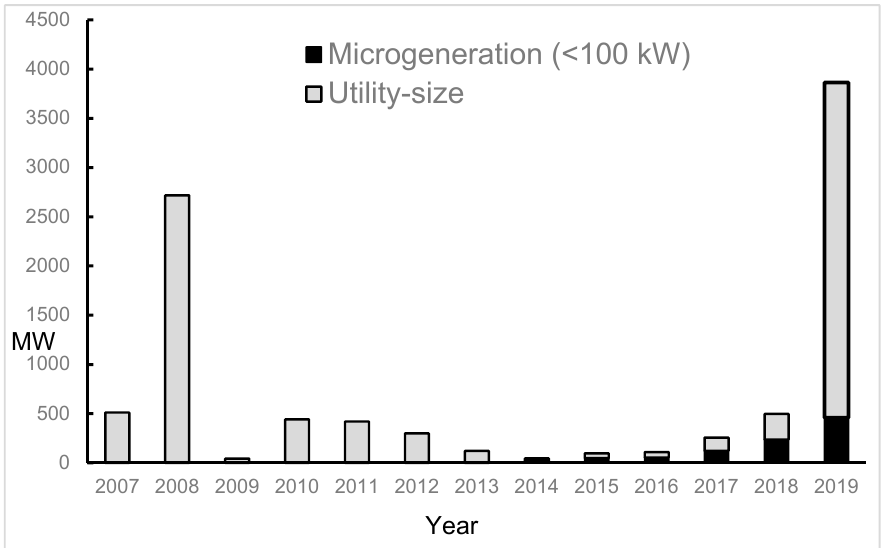
Figure 1. Annual photovoltaic capacity additions in Spain (2007–2019). Source: [38] (pages 41 and 76).